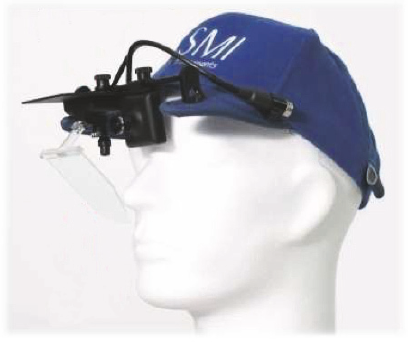
Figure 2: The iView HED4 eye